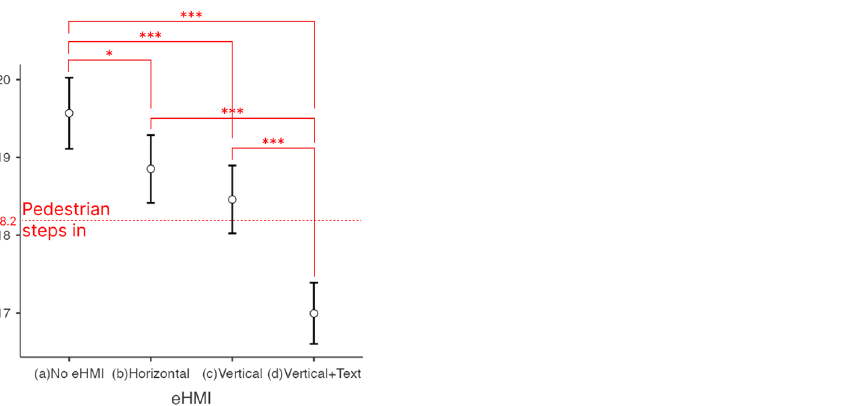
Table 2. Estimated marginal means of time until over 4 reached of the willingness to stop scale by tested cases (seconds).